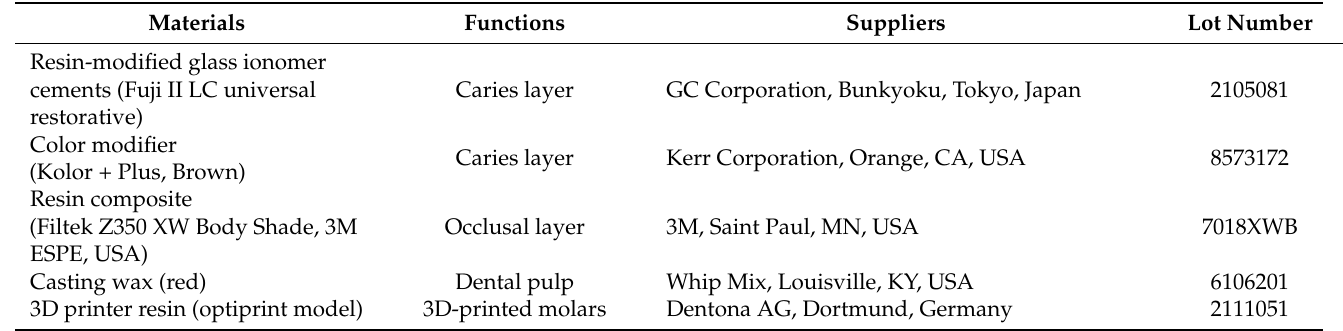
Table 1. The materials used to prepare 3D-printed teeth to practice caries removal in the current